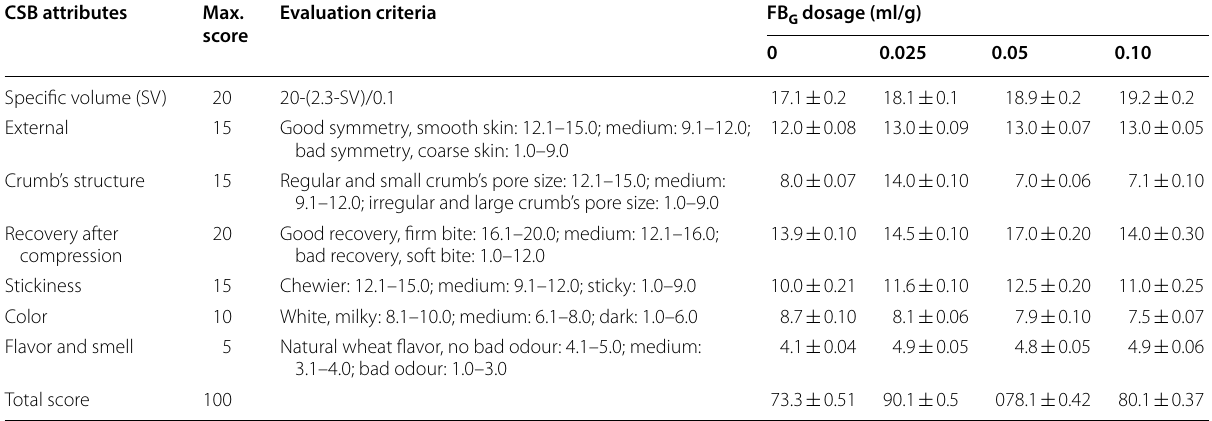
with the different dosages G